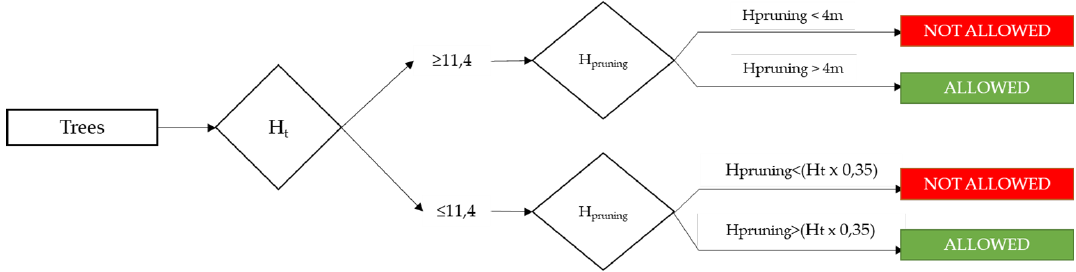
Figure 12. Decision tree, implemented to verify the degree of compliance with the condition of the tree